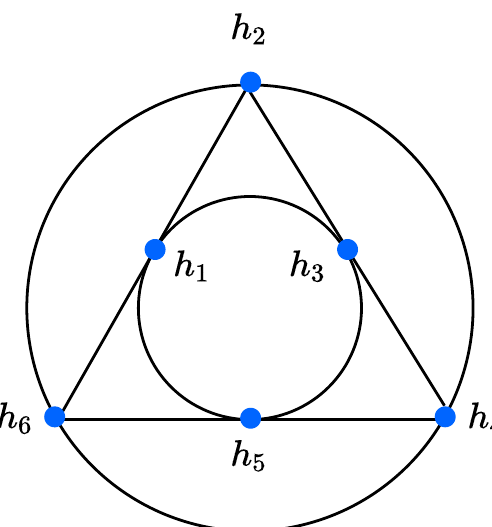
Figure 1: An illustration of the relations between the generators h GC ( 2,6 ) . Each dot corresponds to a generator, and if they are connected via a solid line, they anticommute among each other. If they are not connected, they mutually